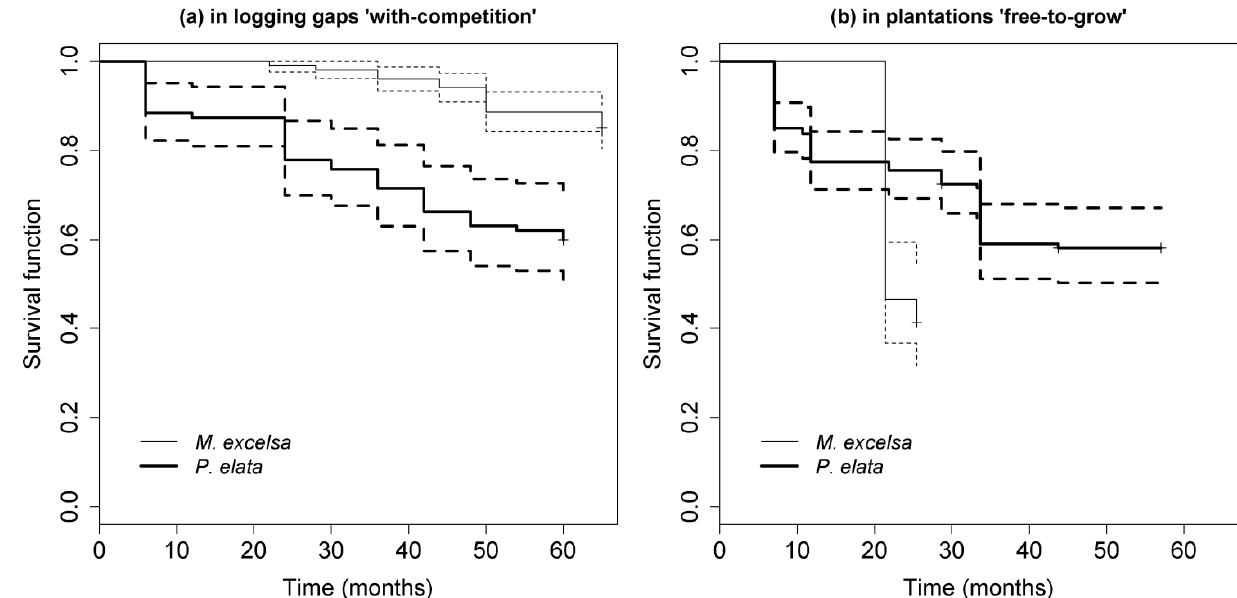
Figure 2. Kaplan-Meier survival estimates over time for M. excelsa and P. elata with their 95% confidence bounds in ( a ) logging gaps-with-competition; and ( b ) plantations-free-to- grow. The survival function of M. excelsa in plantations-free-to-grow may overestimate survival probability in the first 20 months due to the lack of monitoring during the first year. Table 1. Growth performance of M. excelsa and P. elata in logging gaps-with-competition and in plantations-free-to-grow in south-eastern Cameroon. The mean and standard deviation (SD) of height and diameter increment, and relative growth rate in height ( RGR H ) and diameter ( RGR D ) are given for each species in logging gaps-with-competition and in plantations-free-to-grow. The number of seedlings (N) is also given. The letters (a, b) indicate significant differences between species using Welch’s one-way analysis of